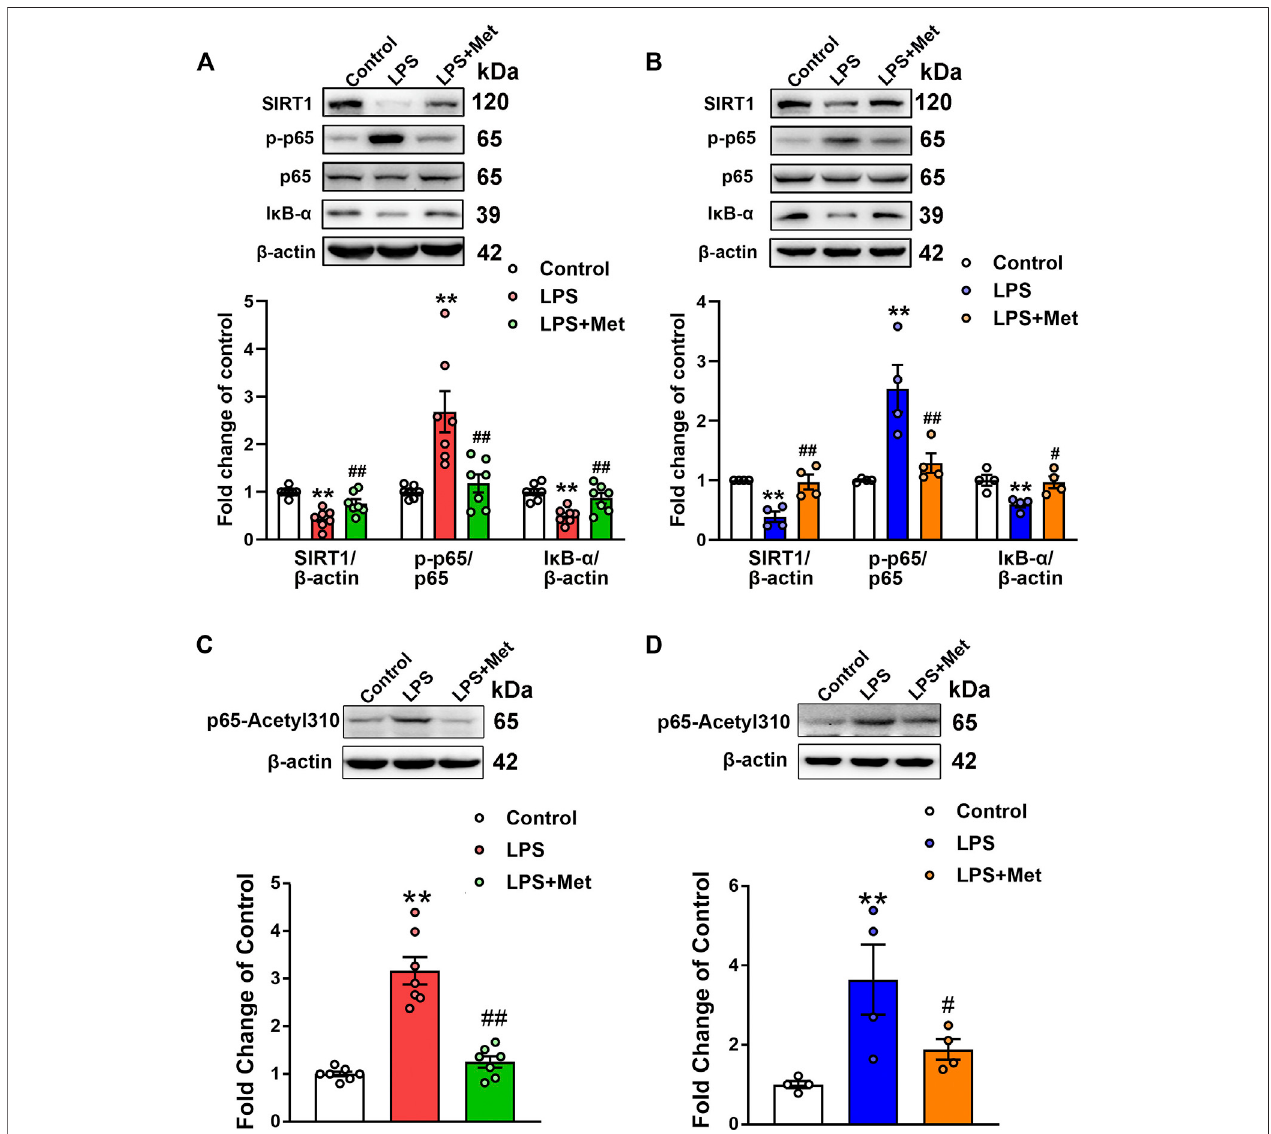
FIGURE4| MetforminsuppressestheLPS-induceddownregulationofSIRT1both invivo and invitro . (A) EffectsofmetforminontheexpressionlevelofSIRT1and NF- κ B signaling pathway in pulmonary tissues of mice that received LPS intratracheally. Indicative bands are shown on the top of the histogram. Data are presented as mean ± SEM ( n = 7). (B) Effects of metformin on the expression level of SIRT1 and NF- κ B signaling pathway in primarily cultured pulmonary ECs. Representative bands areshown.Dataarepresentedasmean±SEM( n =4). (C) Effectsofmetforminontheexpressionlevelofp65lysine310acetylationinLPS-challenged mouselung tissues.Dataarepresentedasmean±SEM( n =7). (D) Effectsofmetforminontheexpressionlevelofp65lysine310acetylationinLPS-treatedpulmonaryECs.Dataare presented as mean ± SEM ( n = 4). ** p < 0.01 vs. Control group, # p < 0.05, ## p < 0.01 vs. LPS group.